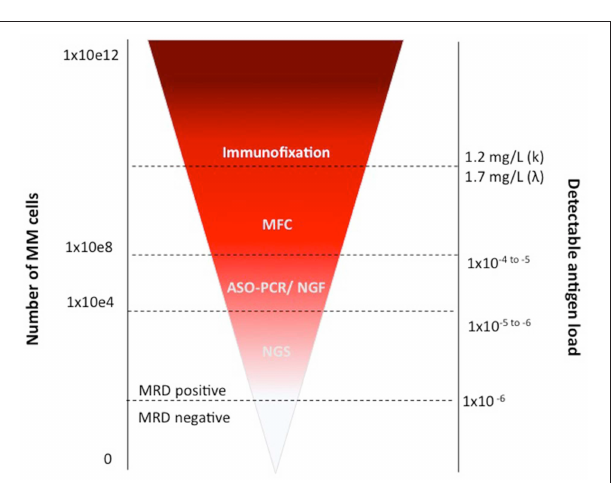
FIGURE 2 | MRD assessment by MFC and